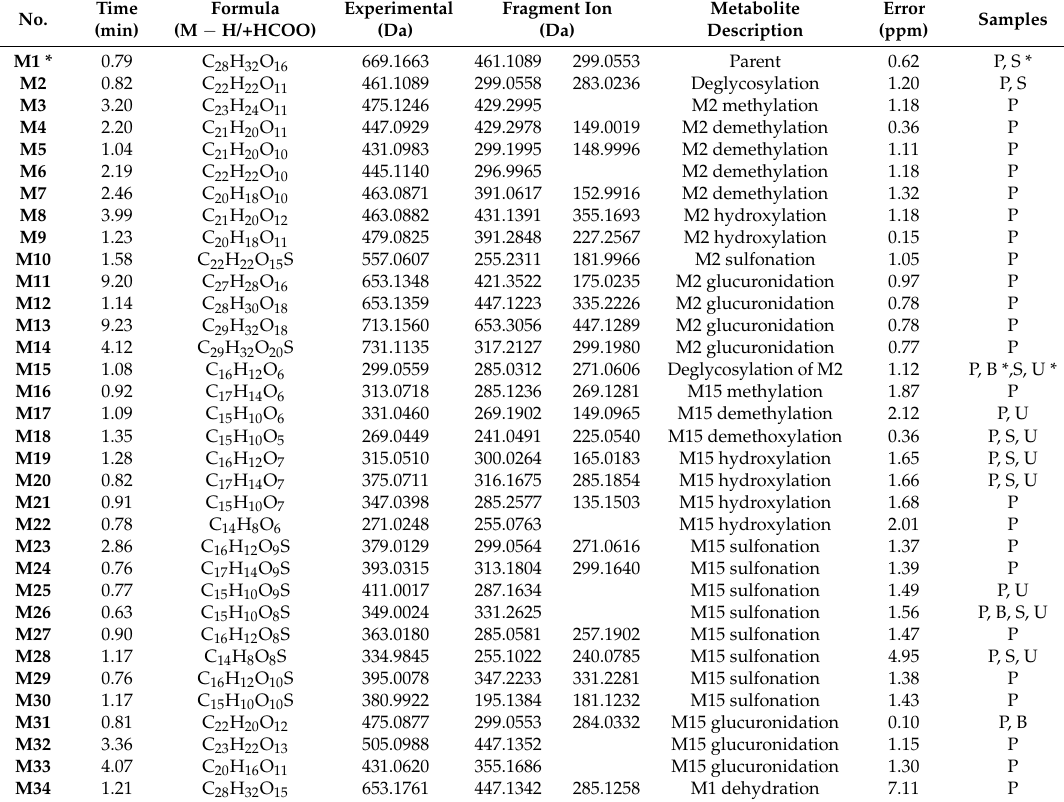
Figure 3. Proposed metabolic pathways of complanatuside.